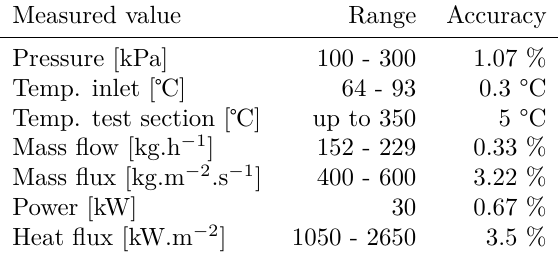
Table 3. Accuracy of measurement